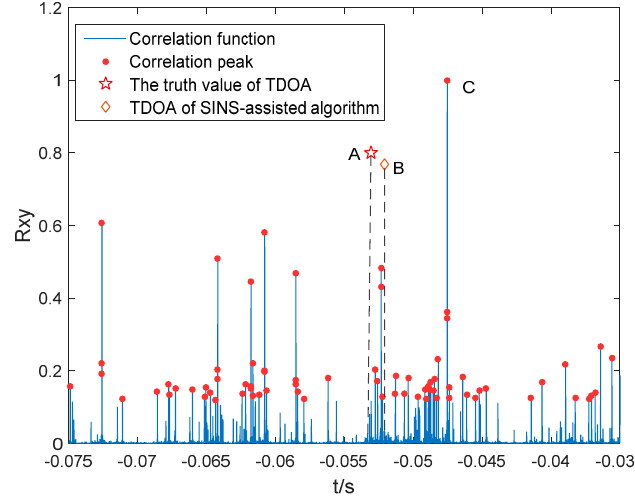
Figure 6. Layout of hydrophones and AUV (Autonomous Underwater Vehicle) position.